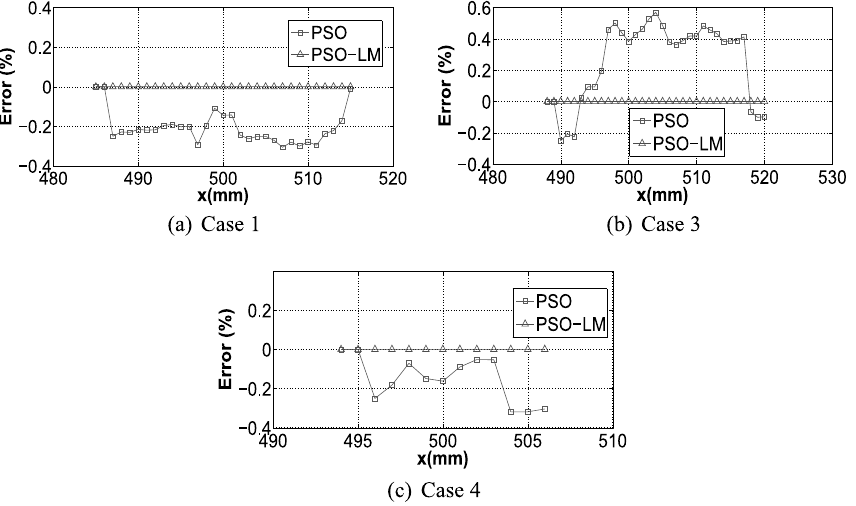
Fig. 4. Relative errors in the cross section area identi fi cation for Cases 1, 3 and